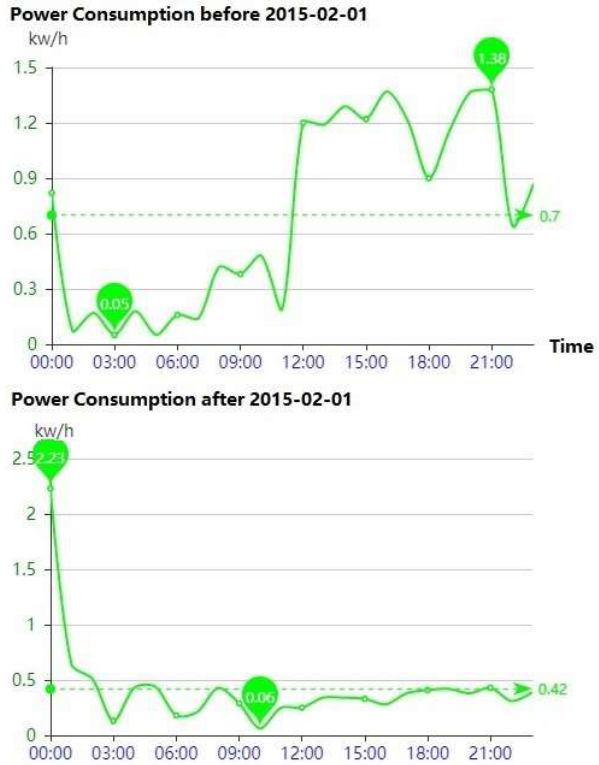
Figure 17. Power consumption curve around 1st February 2015 .